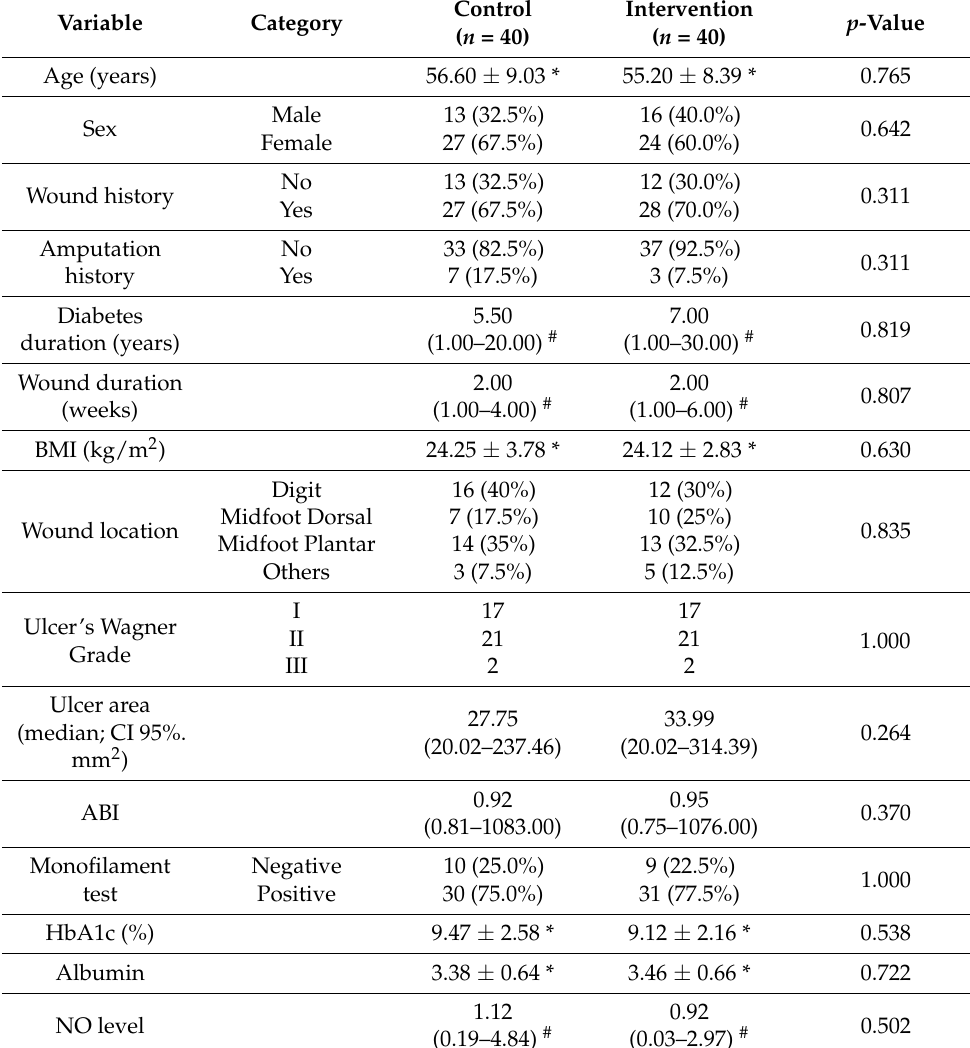
Table 1. Characteristics of patients who participated in this study.